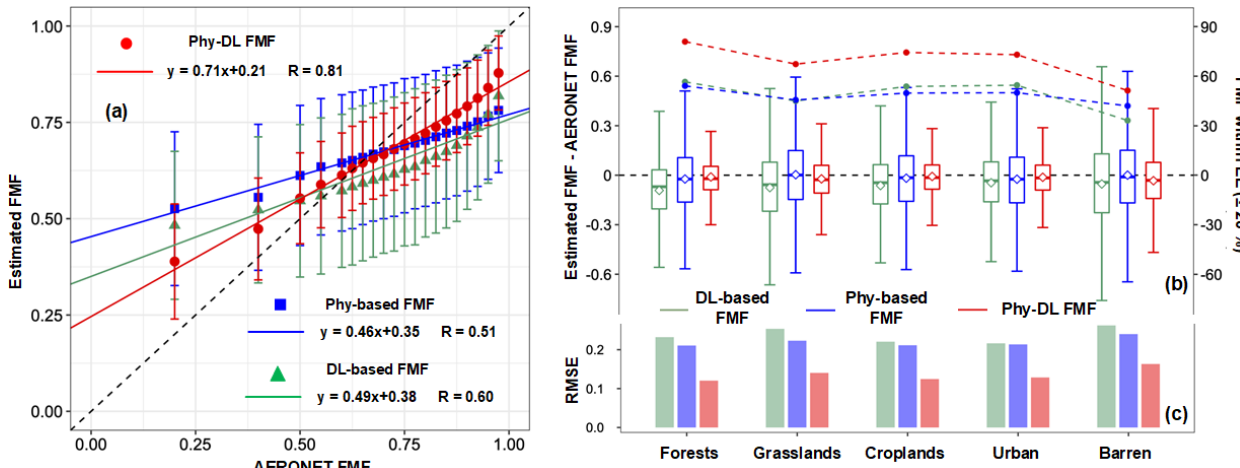
Figure 8. Phy-DL (red), Phy-based (blue), and DL-based FMF (green) estimation compared with AERONET FMFs for AOD > 0.2 (at 500nm, using data from 2008 to 2017). (a) The dots and the error bars indicate the means and standard deviations of the FMF estimates in 20 bins of AERONET FMF. The solid blue and red lines are the best-fit lines from linear regression. The dashed black line represents the 1 : 1 line. Linear regression relations and correlation coefficients ( R ) are given. (b) Boxplots of bias (estimated FMF minus AERONET FMF) and percentage of FMF estimates falling within the EE envelope of ± 20% (dotted, dashed lines) as a function of land type. The upper, middle, and lower lines in each box presents the 75th, median, and 25th percentiles, respectively. The diamond in each box represents the mean value of the FMF bias. (c) The RMSE for each land type against that of the AERONET FMF.